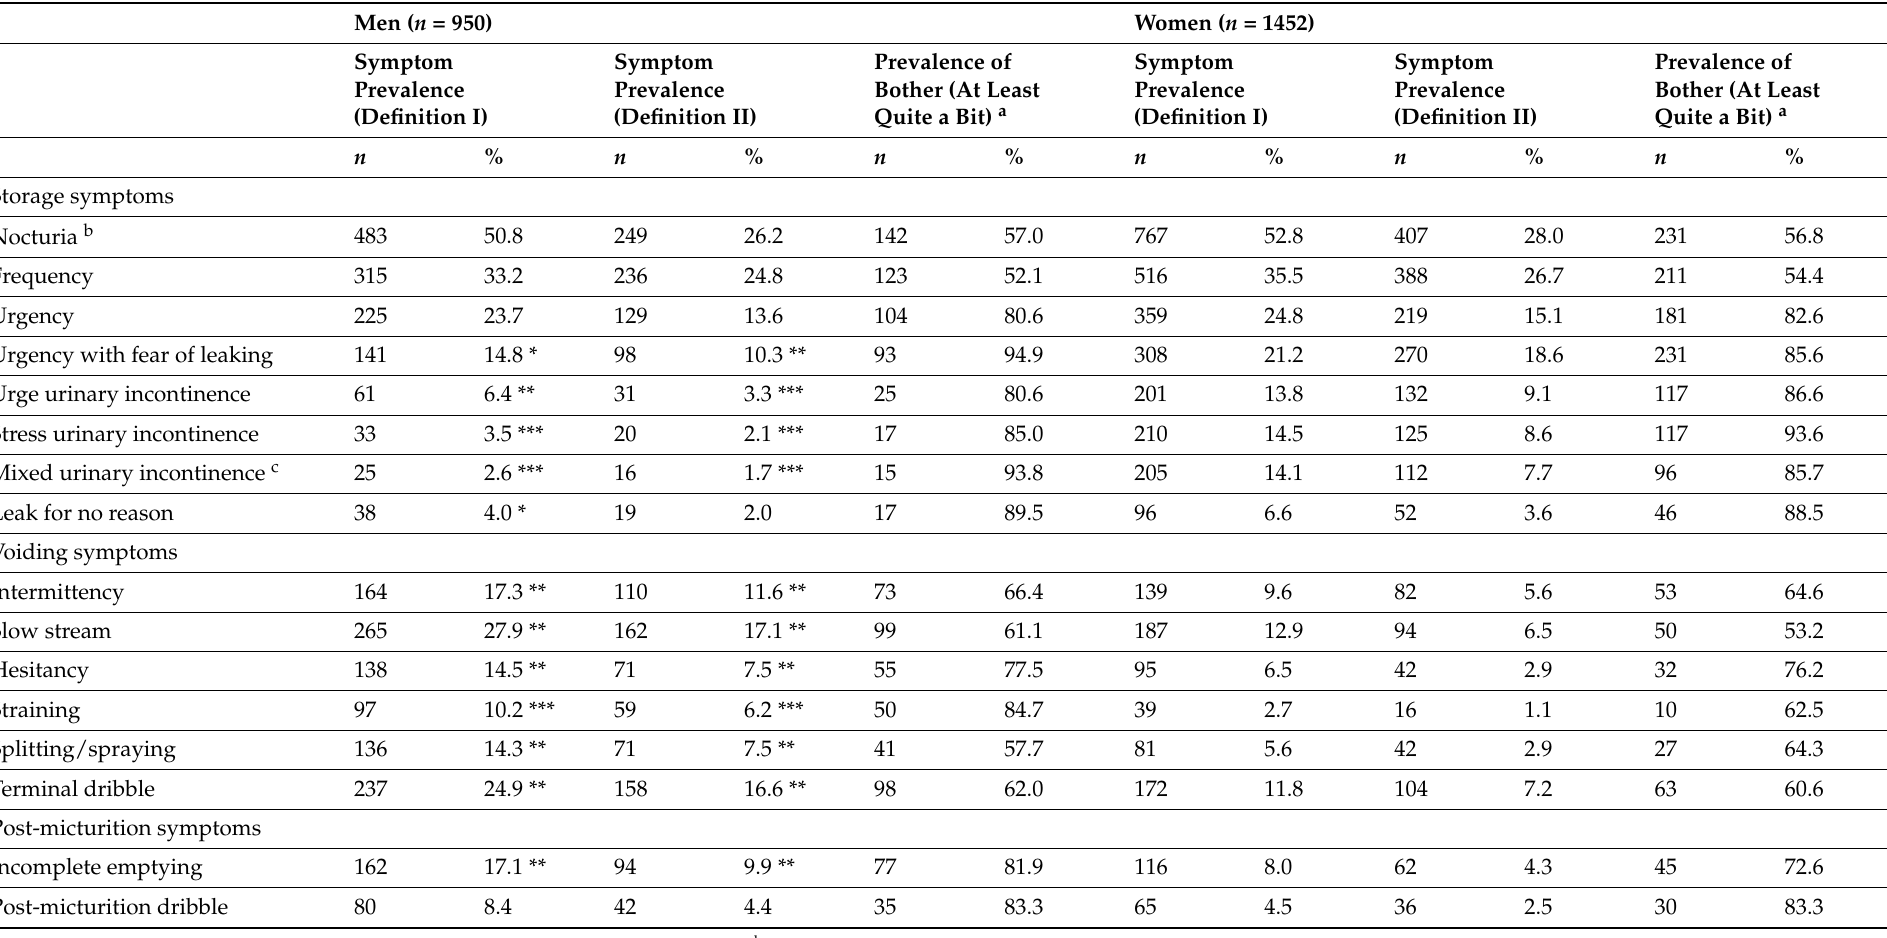
Table 1. Prevalence of specific symptoms according to definition I (symptoms occurring less than half the time or more) and definition II (symptoms occurring about half the time or more) and associated bother in men and women aged 65 years or